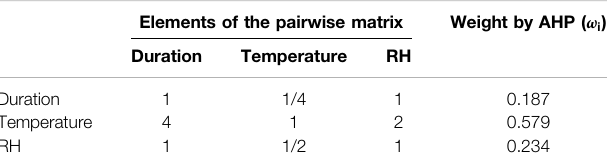
TABLE 5 | Pairwise matrix and the corresponding weights of the three elements for HTHH.